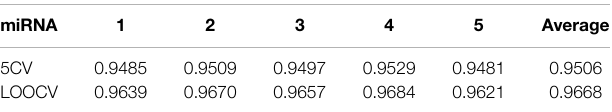
TABLE 1 | Prediction results under different training sets.